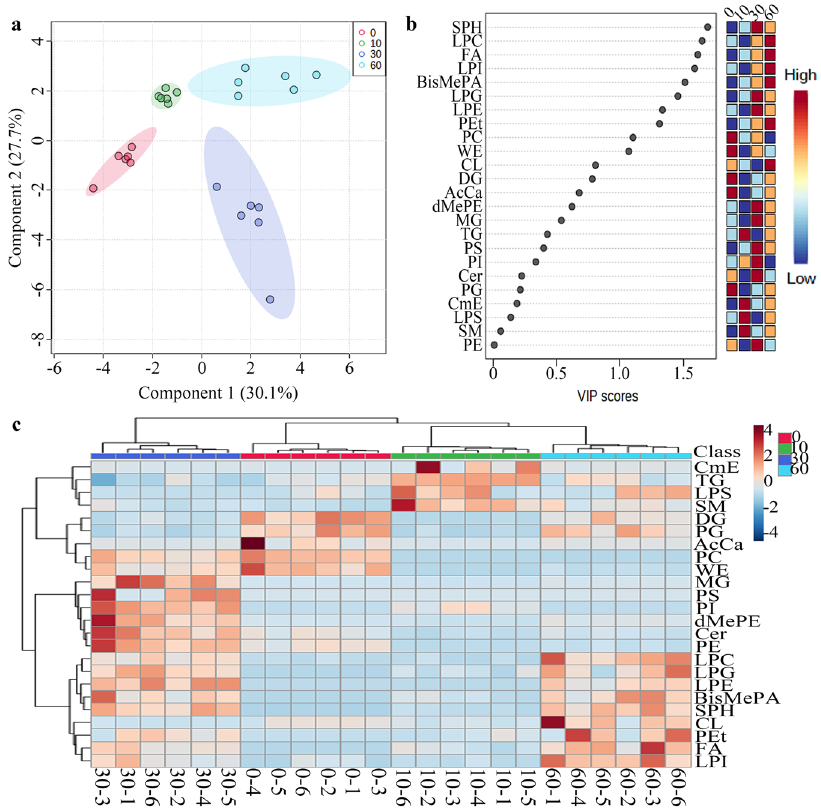
Fig. 5 Statistical analyses of the sum lipid class in tilapia muscle and juice at different steaming times by Metaboanalyst 5.0 software according to the normalized MS data. a PLS-DA score plot. b VIP scores in PLS-DA. c Heat map.